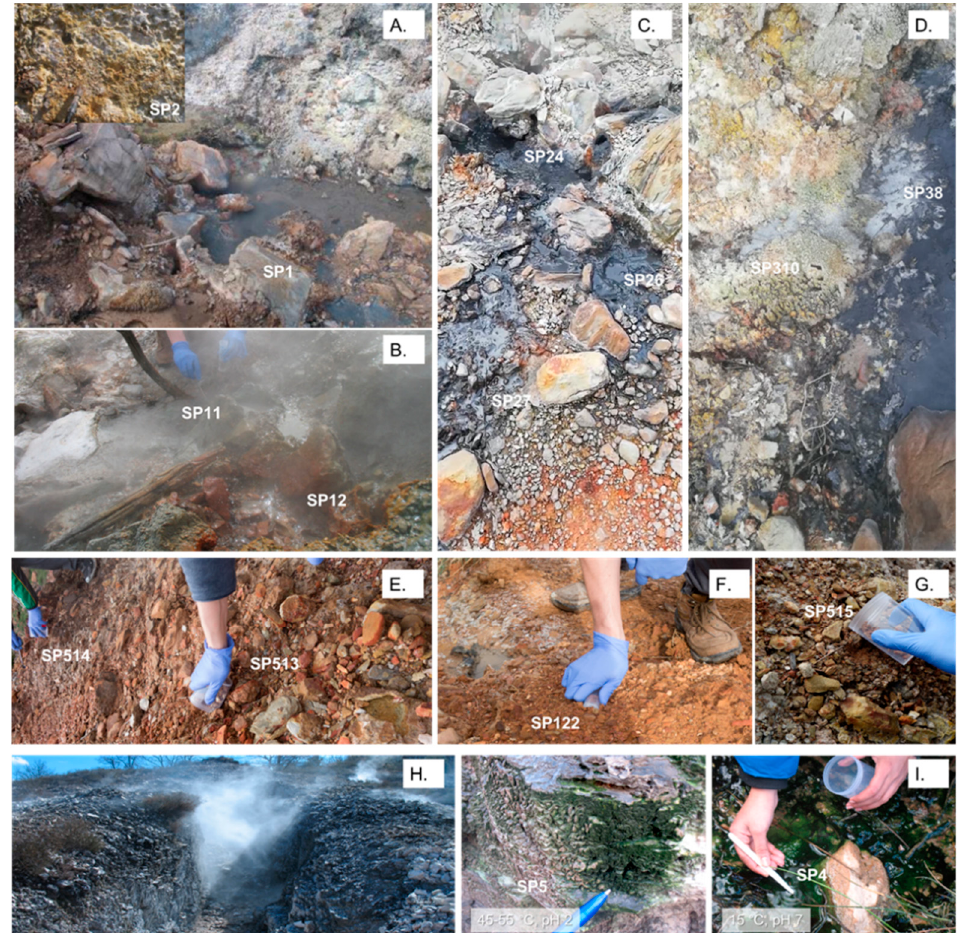
Figure 1. Sampling sites for 16S rRNA and 18S rRNA gene-based analysis. ( A – D ) are hot springs sites, while ( E – G ) are representatives of the soil sampling sites. Each sample is labelled “SP” (Sasso Pisano), followed by numbers. The picture inserted in ( A ) represents the yellowish-orange SP2 sampling site, formed by the surface deposition of the sulphur vapours probably from a solfatara-type vent. Hot spring sites ( A , D ) were either of clear or whitish liquid discharge. Hot springs ( B , C ) were splashing muddy greyish/blackish water. The fumarole rocky wall was continuously wrapped in hot steam ( H ). The greenish biofilm forms a tight layer on the crumbly rock of the fumarole (SP5) and was compared with a cold and pH-neutral water stream (SP4) ( I ).